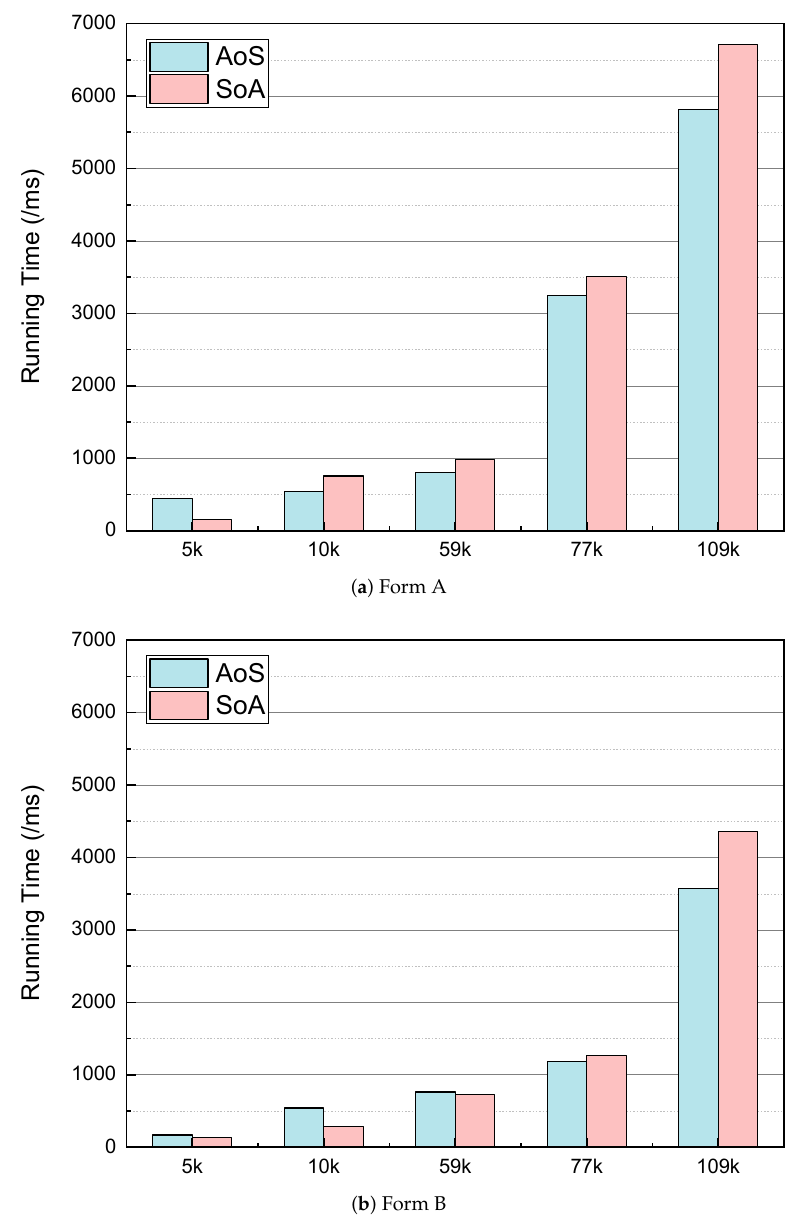
Figure 9. Running time when using different data